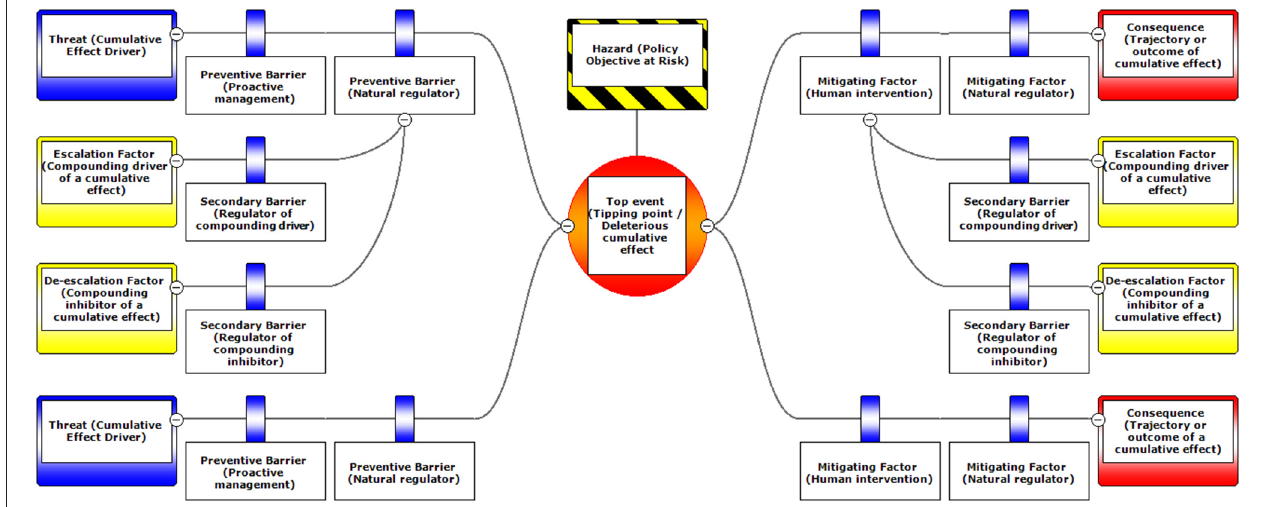
FIGURE 1 | A schematic diagram illustrating the typical layout of BRAT components. Components are labeled with standard BRAT terms or our modified terms (with similar ecological terms in parentheses).